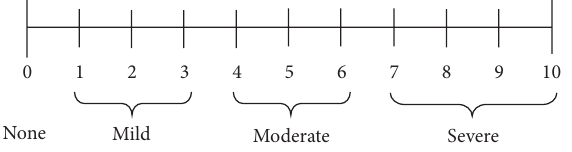
Figure 1: Numeric pain rating scale instructions [28].